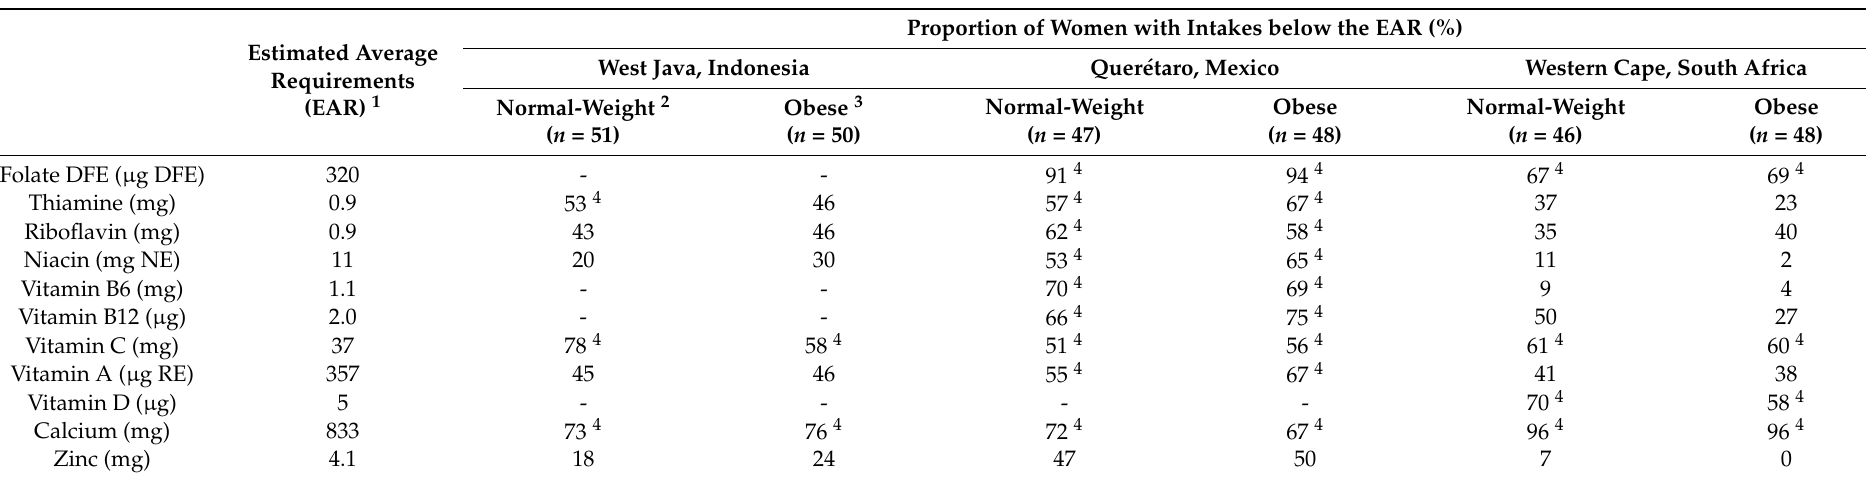
Table 3. Population prevalence of inadequate intakes based on a single 24 h dietary recall by survey area for normal-weight vs. obese women. Estimated Average